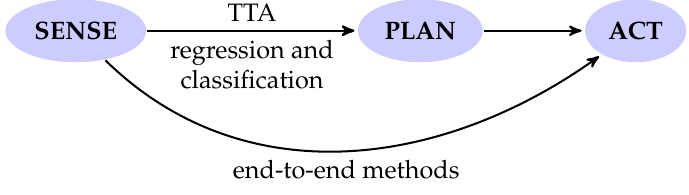
Figure 1. Terrain traversability analysis (TTA) and end-to-end methods